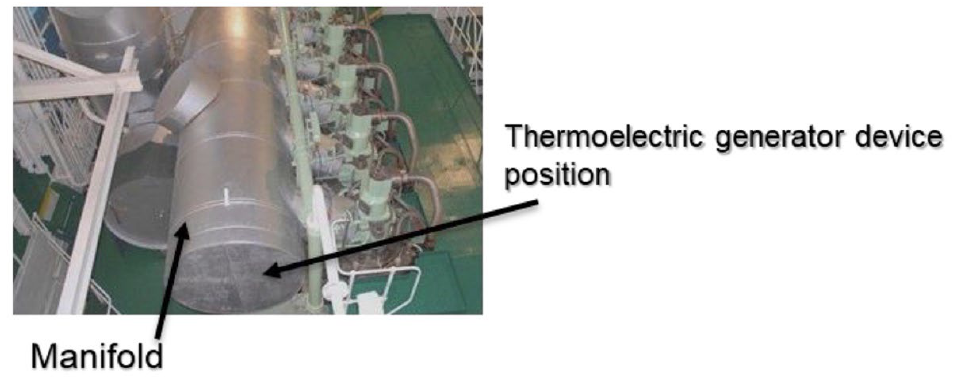
Figure 4. ICE manifold.